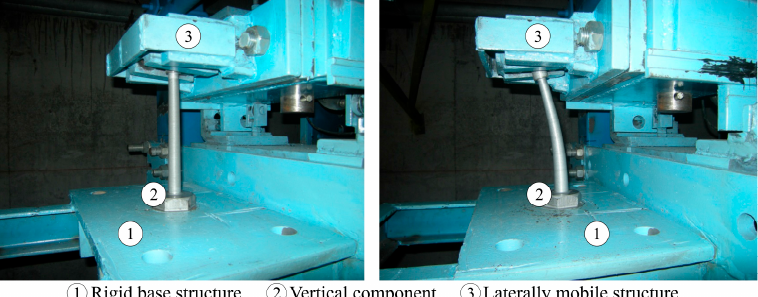
Figure 7. An experimental test setup of vertical components of the energy dissipation device.